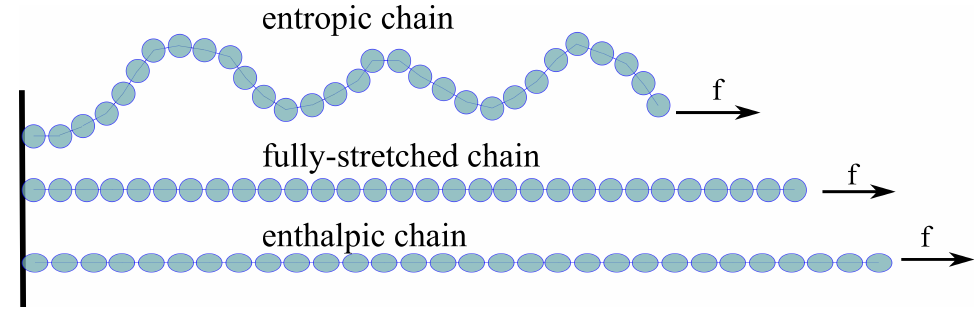
Figure 4. Illustration of the deformation of a polysaccharide chain.